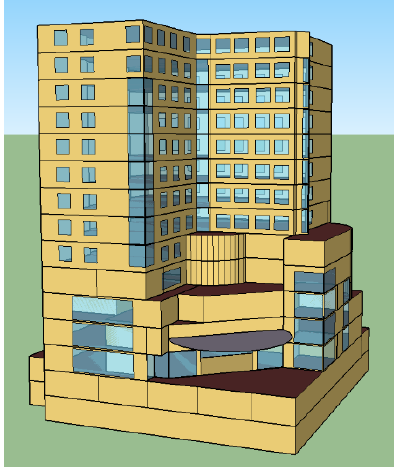
Figure 8. The geometry model of the investigated hotel building.